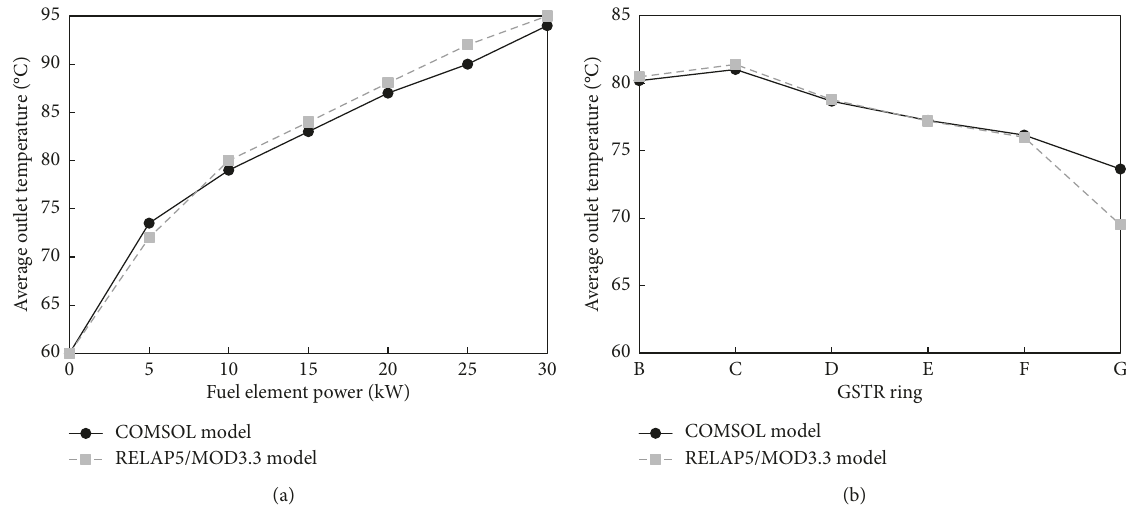
Figure 14: Calculated outlet temperatures in the fuel elements with stainless steel cladding versus the (a) fuel element power and (b) GSTR ring.